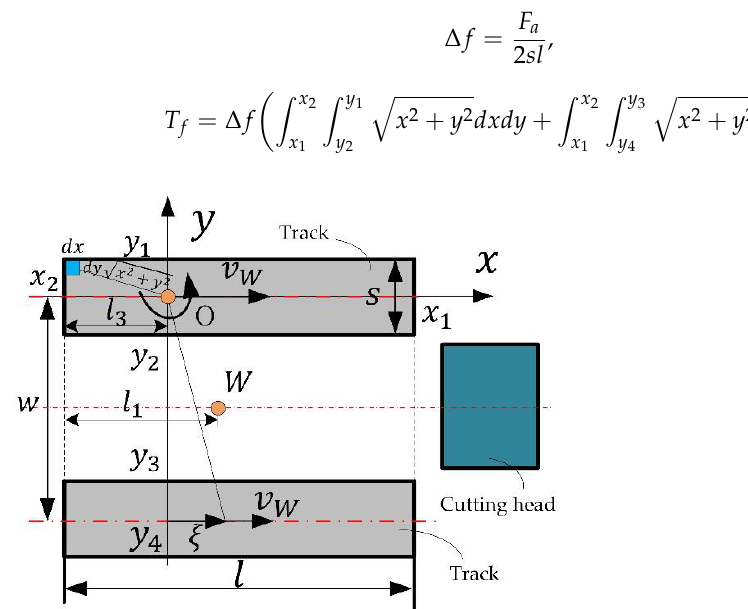
Figure 4. Schematic diagram of anti-skid friction torque of the mining vehicle.